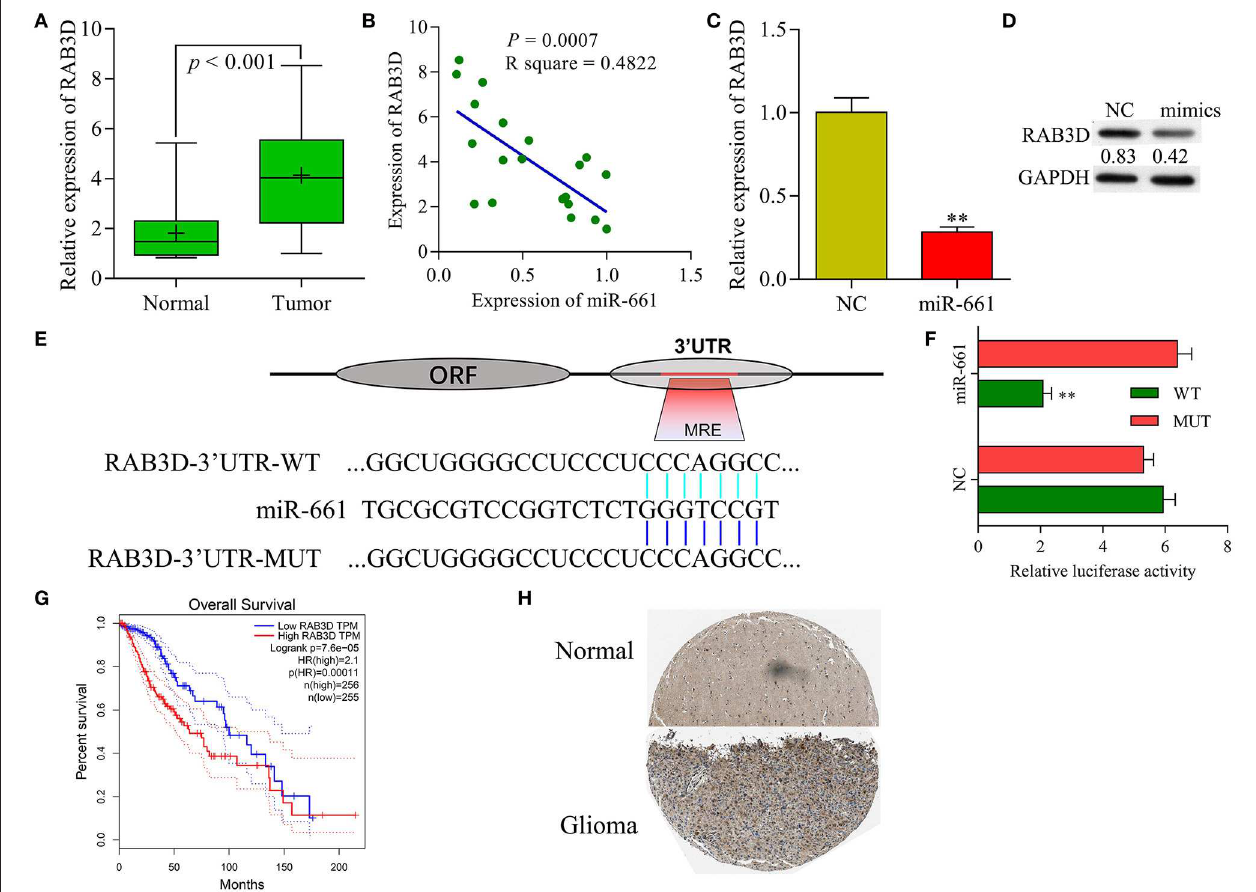
FIGURE 7 | RAB3D served as a target of miR-661. (A) RAB3D mRNA expression in samples of normal and tumor tissues was examined by qRT-PCR. (B) Person’s correlation coefficient was used to analyze the correlation between RAB3D and miR-661. (C,D) RAB3D expression was measured by qRT-PCR and western blot assays after transfection with miR-661 mimics (** P < 0.01). (E) The binding site between RAB3D and miR-661 was identified. (F) 293T cells were co-transfected with WT-RAB3D or MUT-RAB3D and miR-661 or NC; dual luciferase reporter assays were used to analyze relative luciferase activity. (G) GEPIA showing the overall